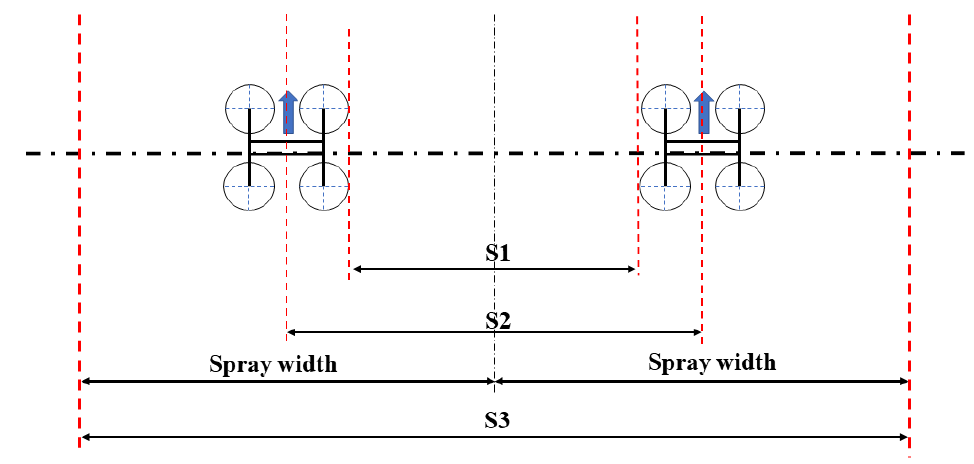
Figure 16. Spatial diagram of spray overlap area.